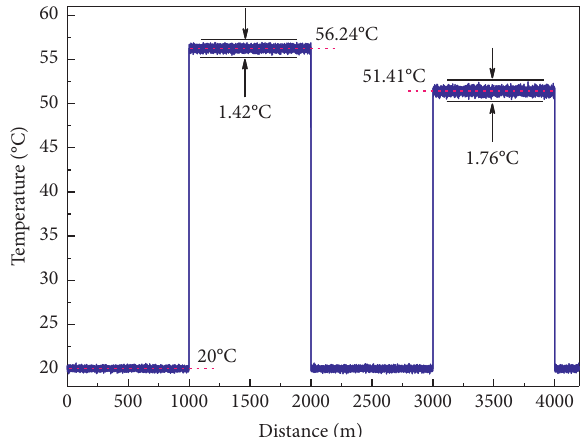
Figure 8: Measured temperature profiles along the FUT, with standard deviation labeled in each heated segment.